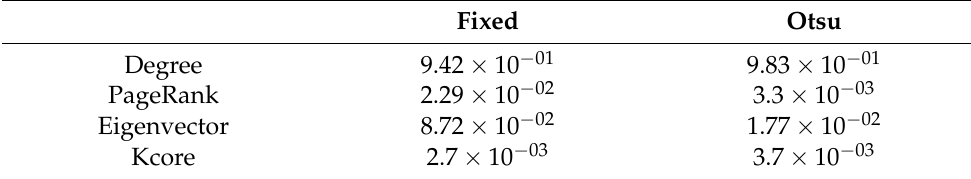
Table 2. p -values from the ANOVA test on window 3.5–5.5 s.